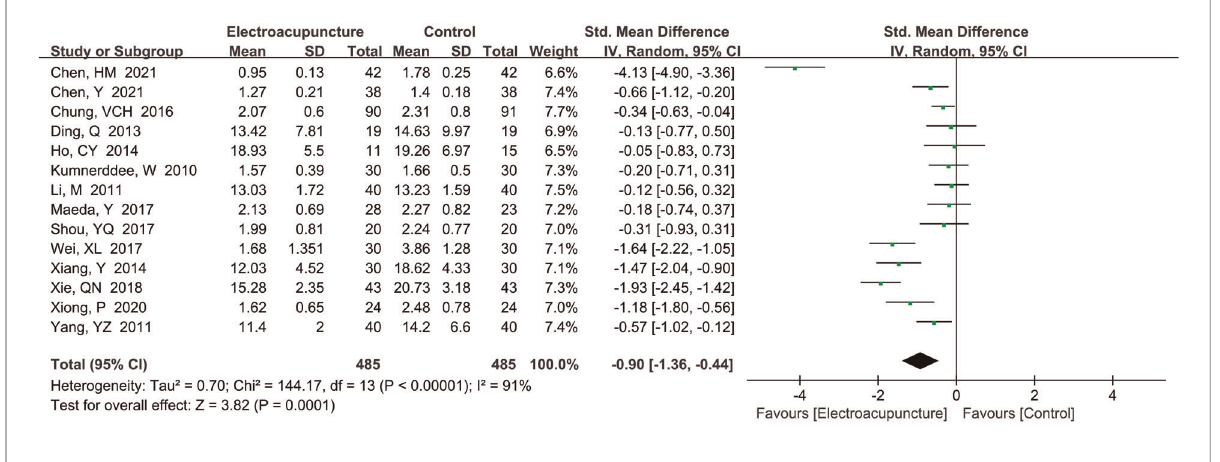
FIGURE 4 A forest plot showing the function scores.